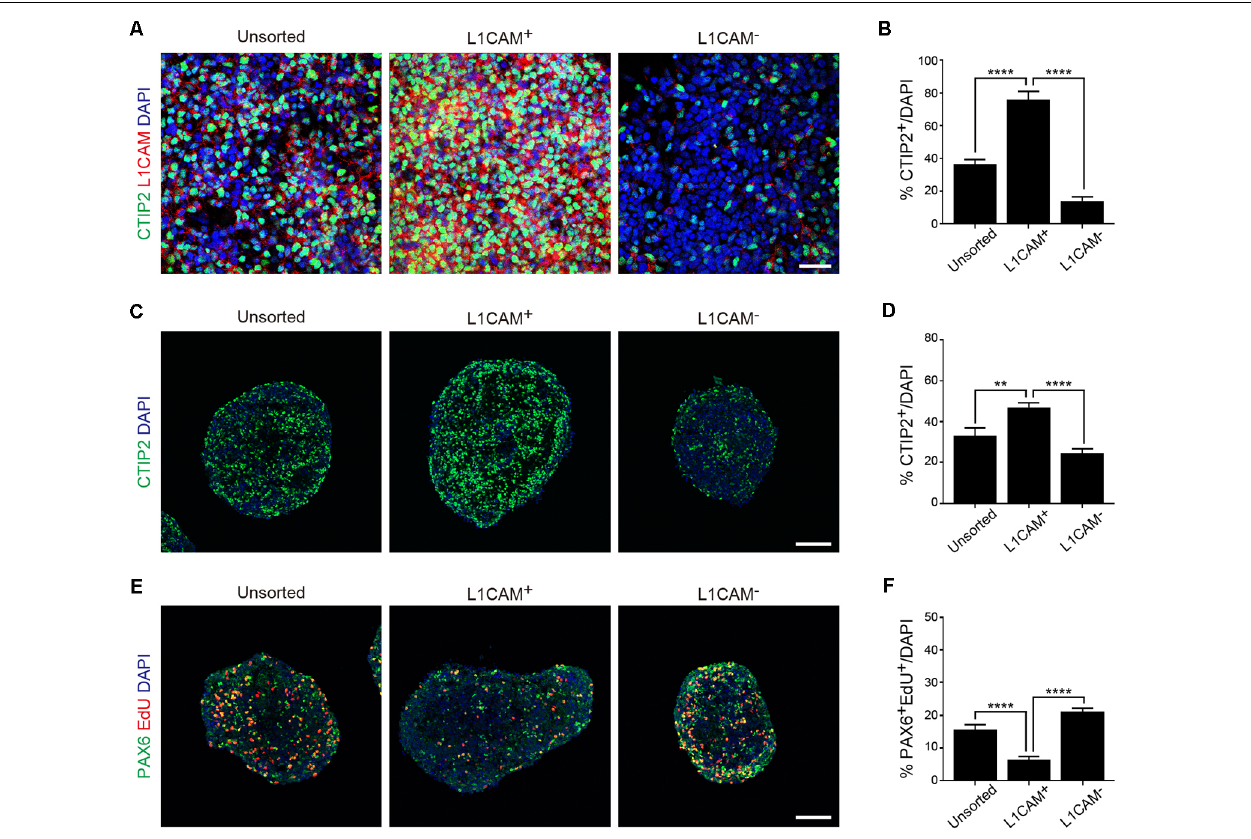
FIGURE 4 | Sorting of L1CAM + cells enriches cortical and migrating neurons. The frontal cortex was taken from E14.5 mice and used for in vitro studies. (A) Immunofluorescence images of the cells from unsorted, L1CAM + and L1CAM − cells for CTIP2 (green), L1CAM (red) and DAPI (blue) several hours after sorting. Scale bar represents 30 µ m. (B) Percentage of CTIP2 + cells in total cells stained with DAPI (unsorted: n = 6; L1CAM + : n = 6; L1CAM − : n = 6). (C) Immunofluorescence images of unsorted, L1CAM + and L1CAM − cells for CTIP2 (green) and DAPI (blue) 2 days after sorting. Scale bar represents 100 µ m. (D) Percentage of CTIP2 + cells in total cells stained with DAPI (unsorted: n = 9; L1CAM + : n = 9; L1CAM − : n = 8). (E) Immunofluorescence images of unsorted, L1CAM + and L1CAM − cells for PAX6 (green), EdU (red) and DAPI (blue) 2 days after sorting. 10 µ M EdU was added in the culture medium 2 h before fixation. Scale bar represents 100 µ m. (F) Percentage of PAX6 + /EdU + cells in total cells stained with DAPI (unsorted: n = 9; L1CAM + : n = 9; L1CAM − : n = 8). All values are displayed as means ± SEM. One-way ANOVA with Bonferroni’s multiple comparison test, ** P < 0.01 and **** P <